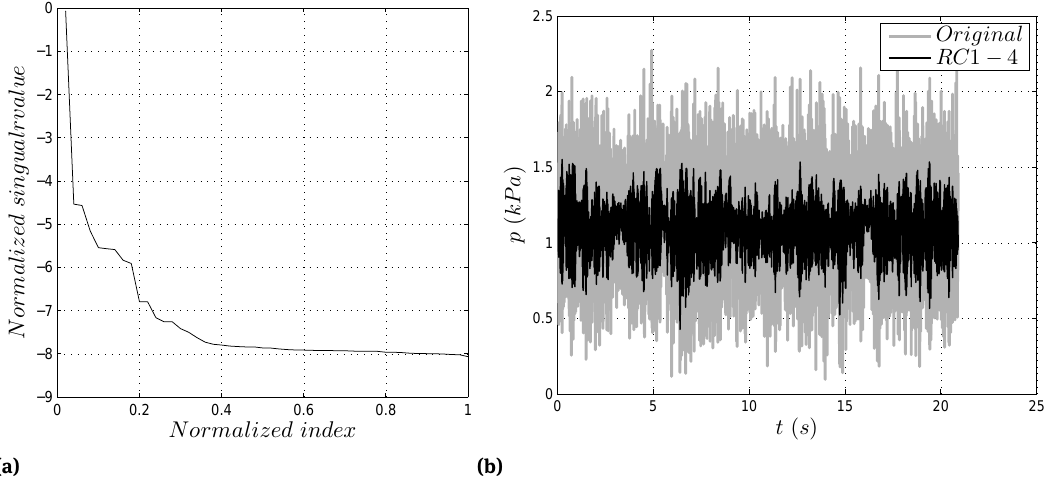
Figure 10: a) Singular value spectra and b) Source signal and sum of its three first principal components at deep surge (TOA = 5%) at the blower inlet